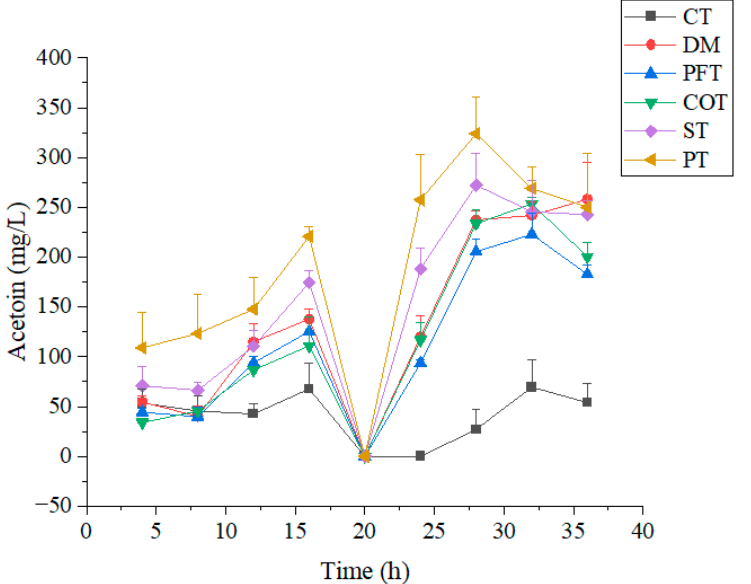
Figure 4. Changes in acetoin in culture medium containing molasses with different treatment methods. Molasses with different treatment methods (170 mL/L) was added into culture medium. DM represents untreated molasses. ST, PT, PFT, COT and CT represent sulfuric acid treatment process, phosphoric acid treatment process, potassium ferrocyanide treatment process, calcium phosphate tribasic treatment process, combinational treatment process, respectively. Data were obtained from triplicate tests and shown as mean ± SD.